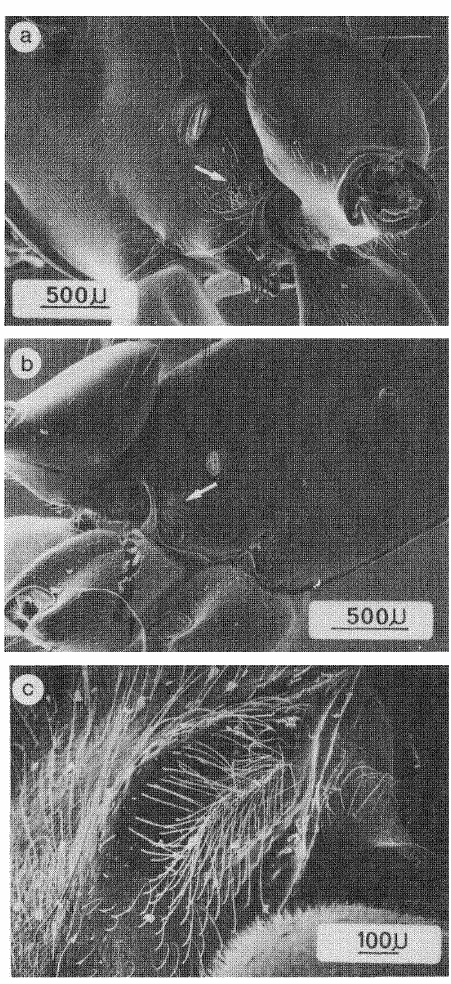
Fig. 5. (Above and facing page) SEM micrographs of the mesosoma of workers of several formicine species. Arrow indicates region where the opening of the metapleural gland should be located, a. Camponotuspenns.vlvanicus; b. Campo- horus consobrinus. In both species there are clusters of hairs visible in the area of the metapleural gland opening. Both species, however, lack a slit-shaped opening. c. The slit-shaped opening of the metapleural gland of Camponotus gigas. No opening can be detected in d. Colohopsis truncata; e. Dendromyrmex chart(/’ex; f. Pol.vrhachis C.vrtom.vrma)?